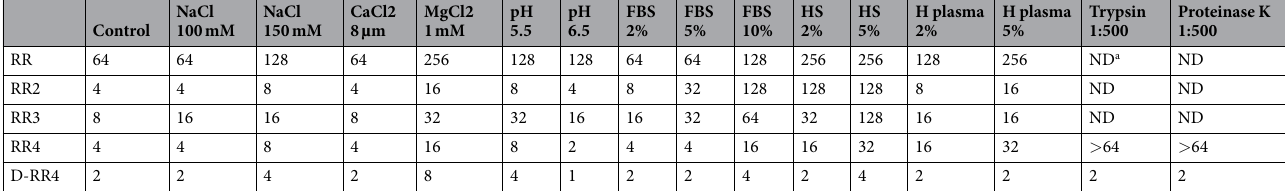
Table 4. Minimum inhibitory concentration values of designed peptides in the presence of salts, pH 5.5 or pH 6.5, fetal bovine serum (FBS, 2%, 5% or 10%), human serum (HS, 2% or 5%), and plasma from human donors